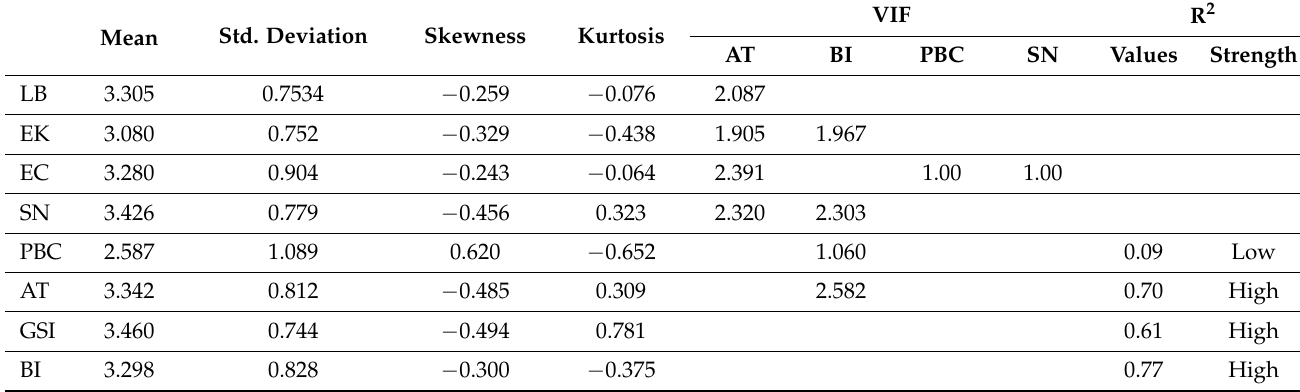
Table 6. Variance Inflation Factor (VIF) & R 2